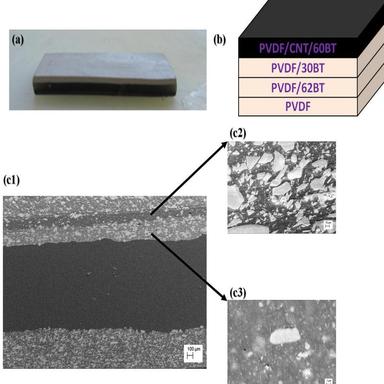
Multi-layered slabs obtained by stacking of solvent casting films, alternating the different compositions: (a) macroscopic picture of the obtained M1 slab; (b) schematization of M1 design, on the basis of the carried out simulation, (c) SEM micrograph of M1 polished cross section ((c1) and (c2): higher magnifications SEM micrographs of selected areas).